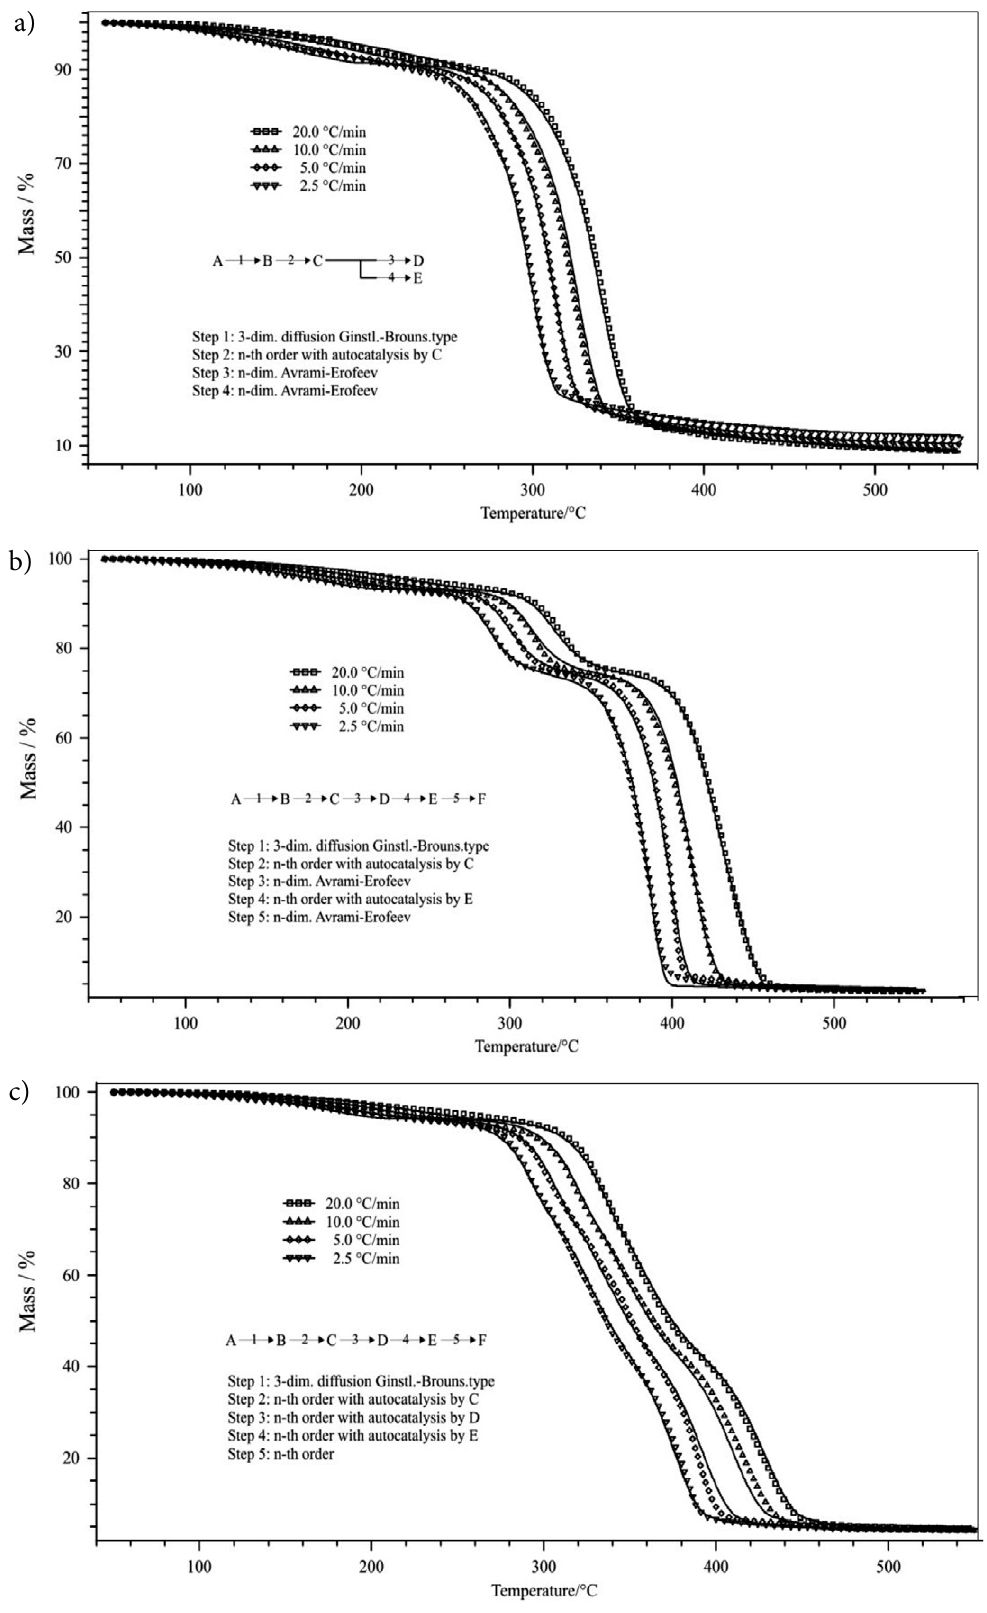
Fig. 6. Comparison of experimental data (points) and best fitted kinetic models (solid lines) calculated from multivariate nonlinear regression meth- od for the TPS (a), PCL/TPS (b) and PCL/PLA/TPS (50/50/30)